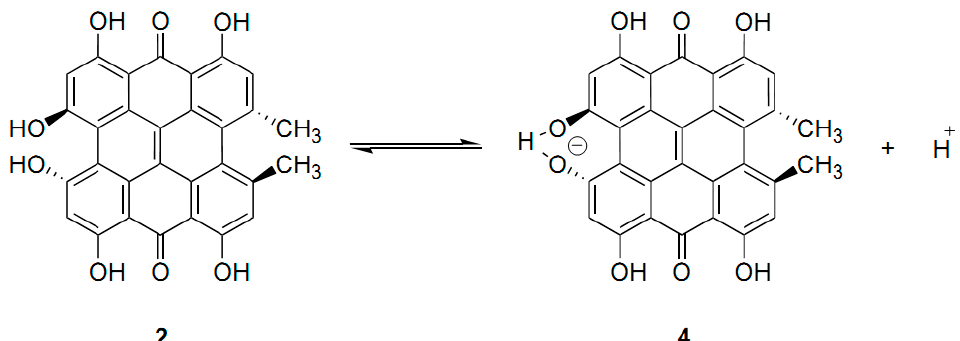
Figure 11. Solvent dependent equilibrium of 7,14 -dioxo tautomer of hypericin HyH, Q 7,14 ( 2 ), and its anionic stable form Hy − ( 4 )